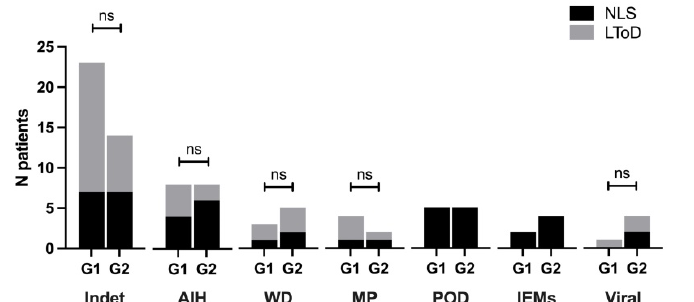
Figure 4. Comparison of the outcomes of patients with ALF according to era and aetiology. LToD: liver transplant or death on waiting list. NLS: native liver survival; G1: group 1. G2: group 2. AIH: autoimmune hepatitis; WD: Wilson disease; MP: mushroom poisoning; POD: paracetamol overdose; IEMs: inborn errors of metabolism; ns: not signi fi cant.